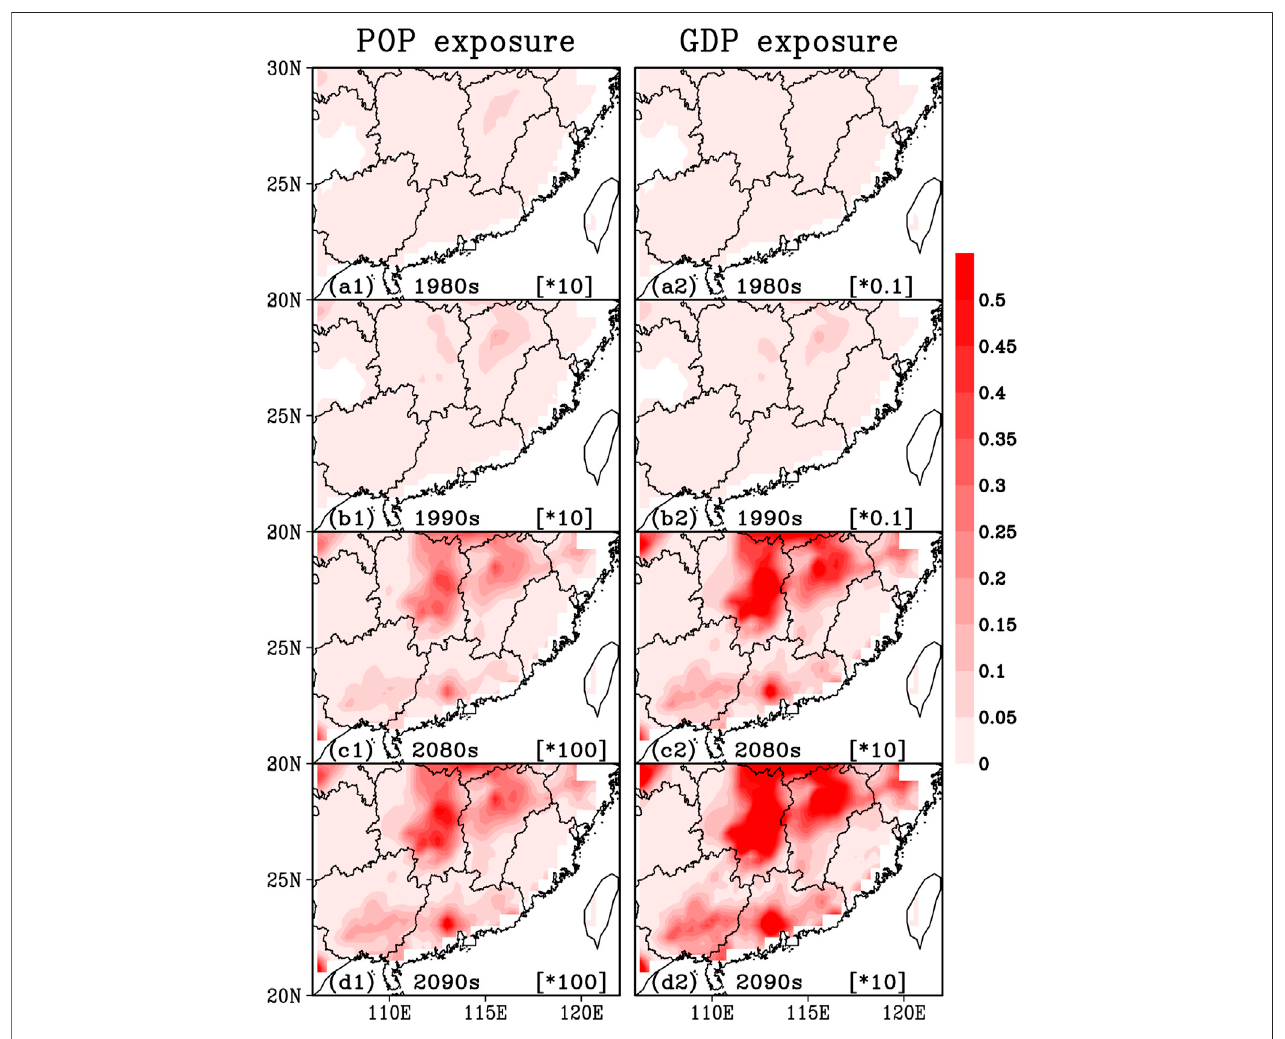
FIGURE 7 | Same as Figure 6 , but for exposure to temperature larger than 38 °